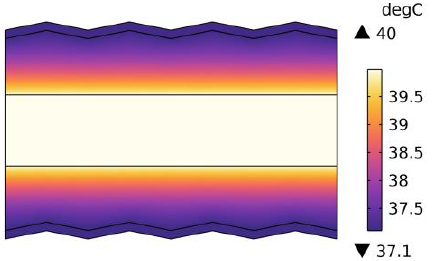
Figure 5. Distributions of ( a ) the thermal field and ( b ) the flow field when transmitting a 100 W electromagnetic wave at 1 GHz.